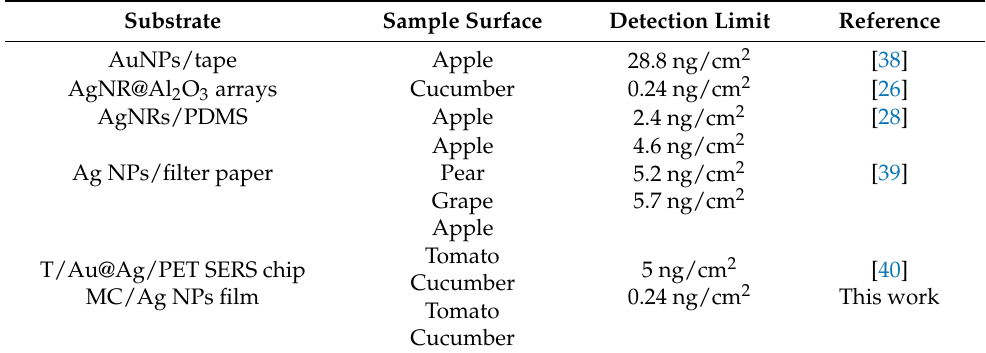
Figure 6. SERS spectra of thiram residues extracted from ( A ) cucumber peel, and ( B ) tomato peel using the MC/Ag NPs film substrate. Table 1. Comparison of the SERS detection performance for thiram using flexible substrates .